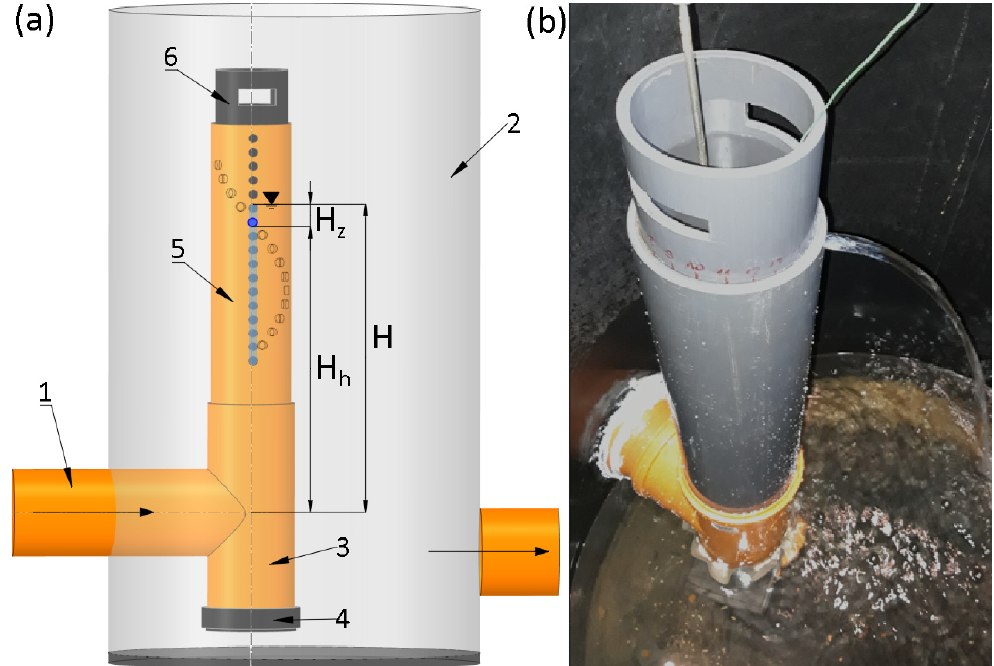
Figure 3. Measurement scheme ( a ) and photo ( b ) of a hole regulator: 1—drain; 2—drainage well; 3—tee; 4—drain plug; 5—outer pipe; 6—inner pipe; H h —height of the open hole above the drain axis; H z —water depth in the shaft pipe above the opened hole; H—height of the water level in the shaft pipe in relation to the drain axis.